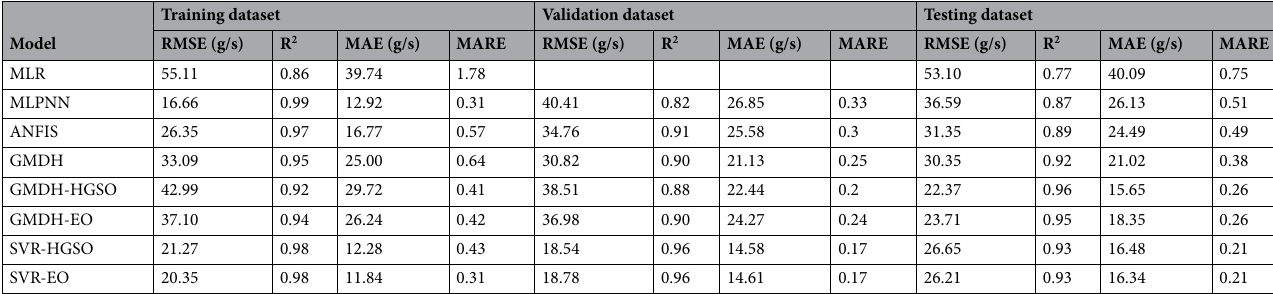
Table 3. Statistical indices of the proposed model in the training, validation and testing